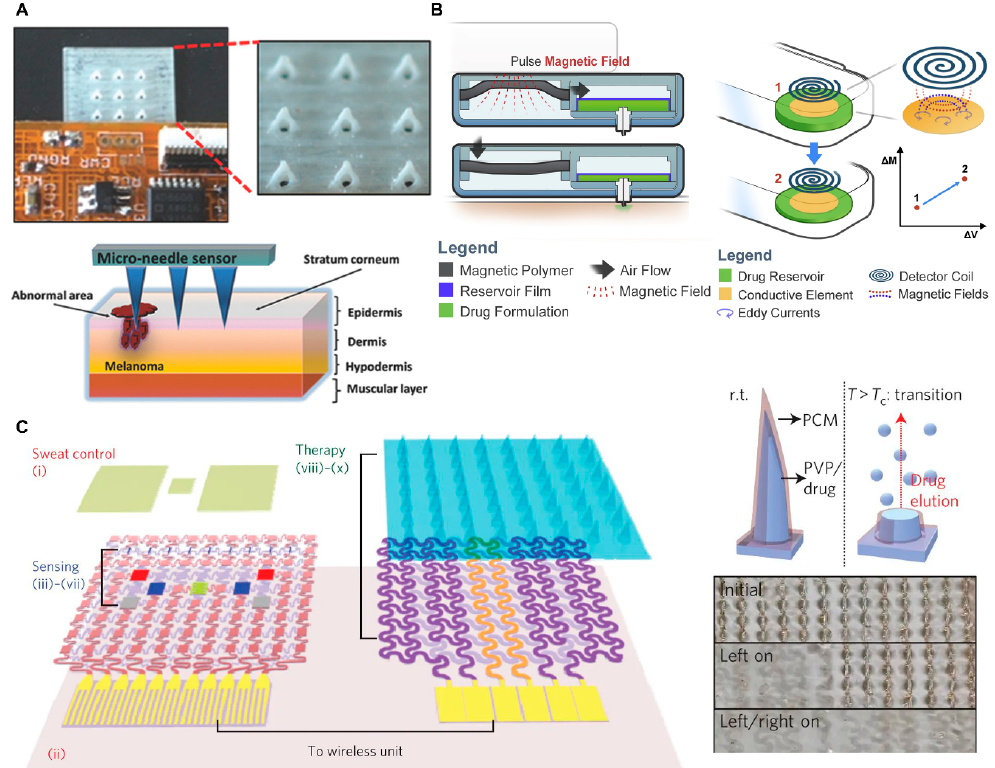
Figure 8. ( A ) Photograph of MN integrated with flexible electronics (top) and schematic illustration of melanoma biomarker detection using MN (down) (reproduced with permission from the authors of [164] ). ( B ) Schematic illustration of pneumatic-hydraulic actuator system used for wireless drug delivery (left) and related inductive sensing principal (right) (reproduced with permission from the authors of [165] ). ( C ) Schematic illustration of diabetes sensing and therapy patch (left), drug releasing principal of MN (right top), and photograph of heater controlled stepwise MN dissolution (right down) (reproduced with permission from the authors of [166] ).